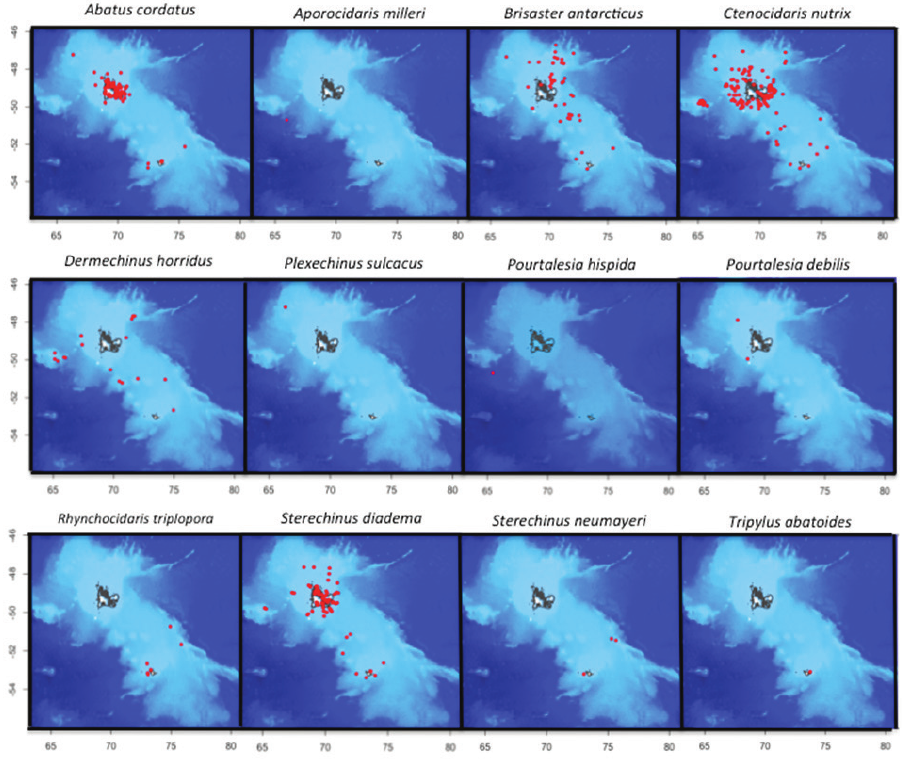
Figure 2. Distribution of the 12 echinoid species based on the specimens collected since 1872 on the Kerguelen